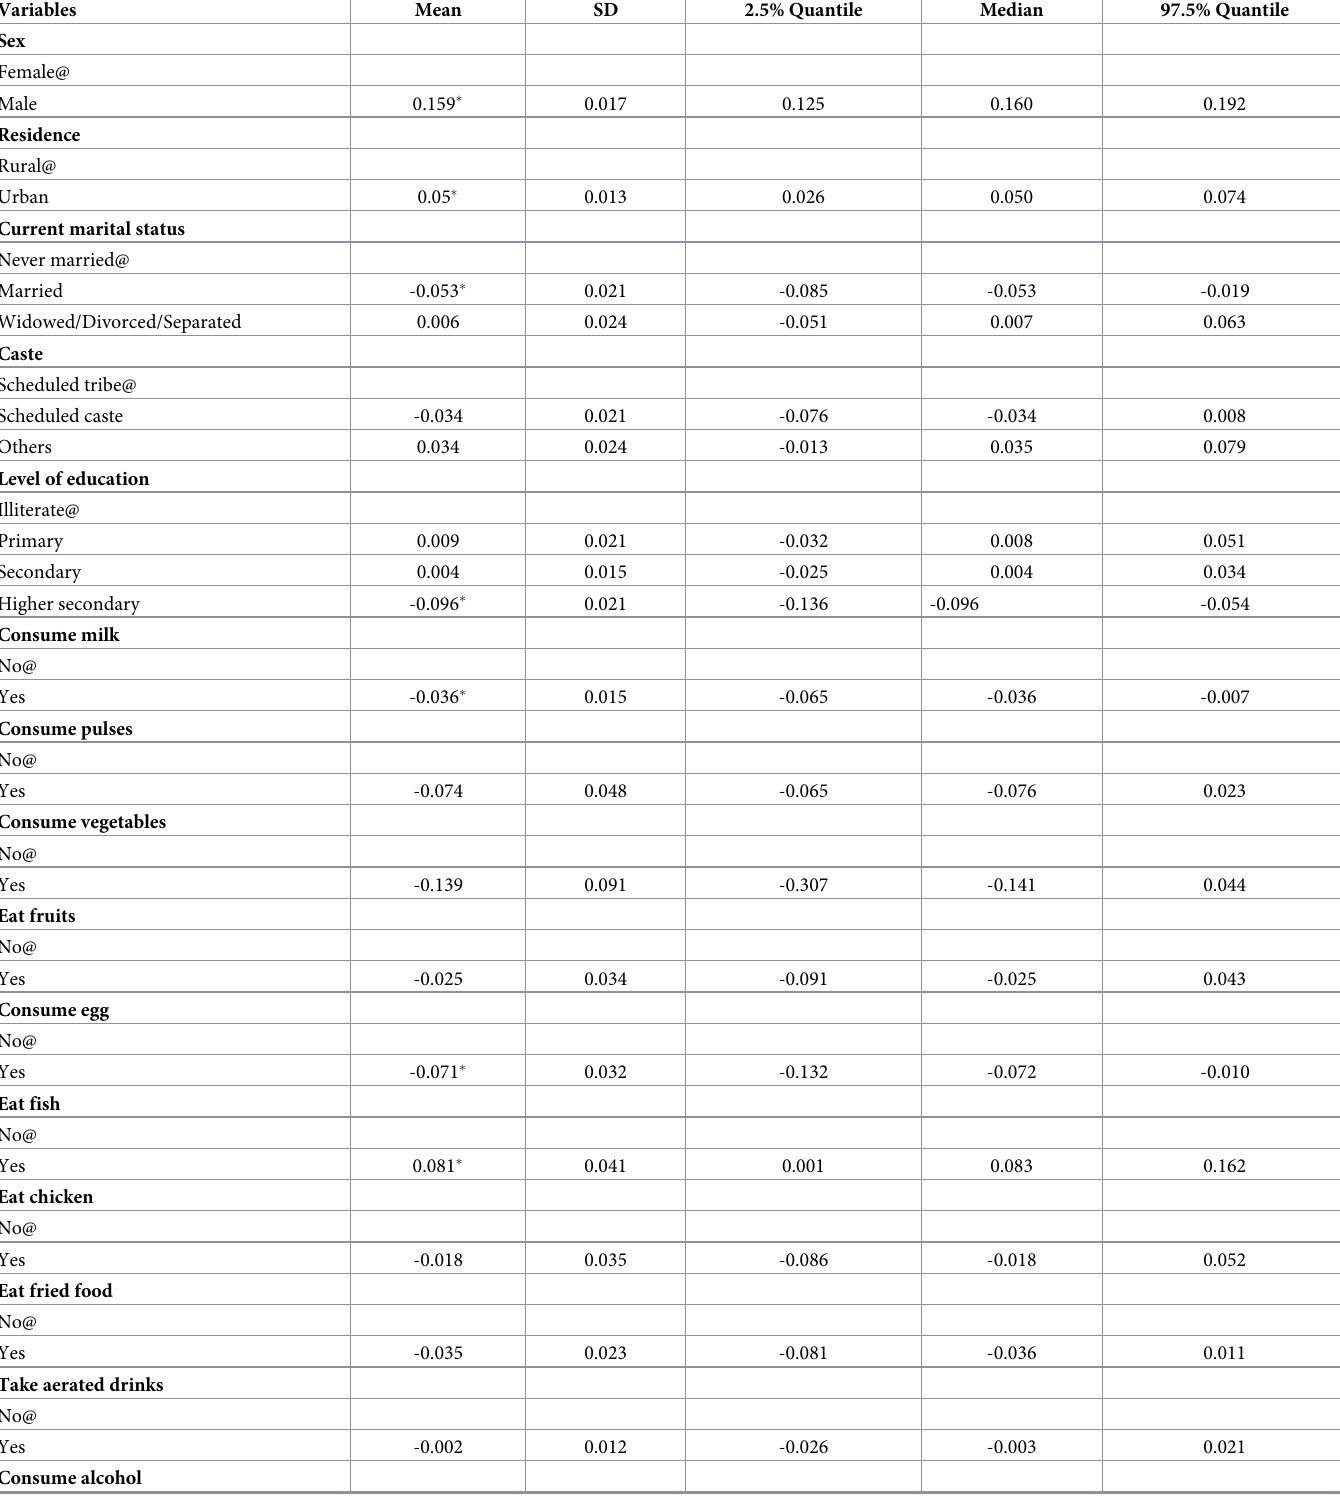
Table 4. Posterior estimates of the fixed effects parameters for hypertension in Northeast